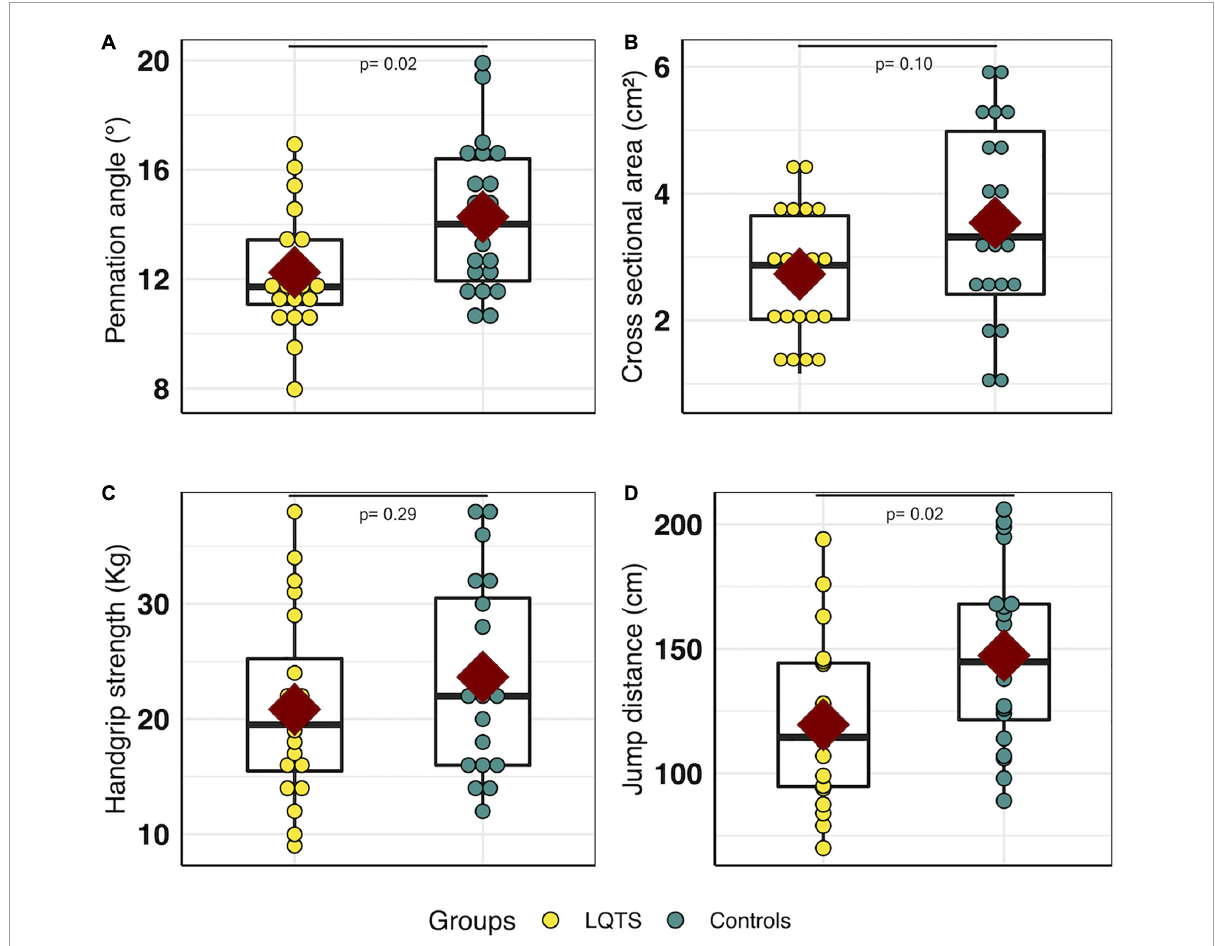
FIGURE3 Muscle fitness comparison between LQTS and control groups. (A) Pennation angle ( ◦ ). (B) Anatomical cross-sectional area (cm 2 ). (C) Handgrip strength (kg). (D) Standing long broad jump distance (cm). For each group, the dark red square represents the mean value for each group, the black boxplot represents the first, second, and third quartiles [e.g., Q1, median, Q3], respectively. LQTS, long QT